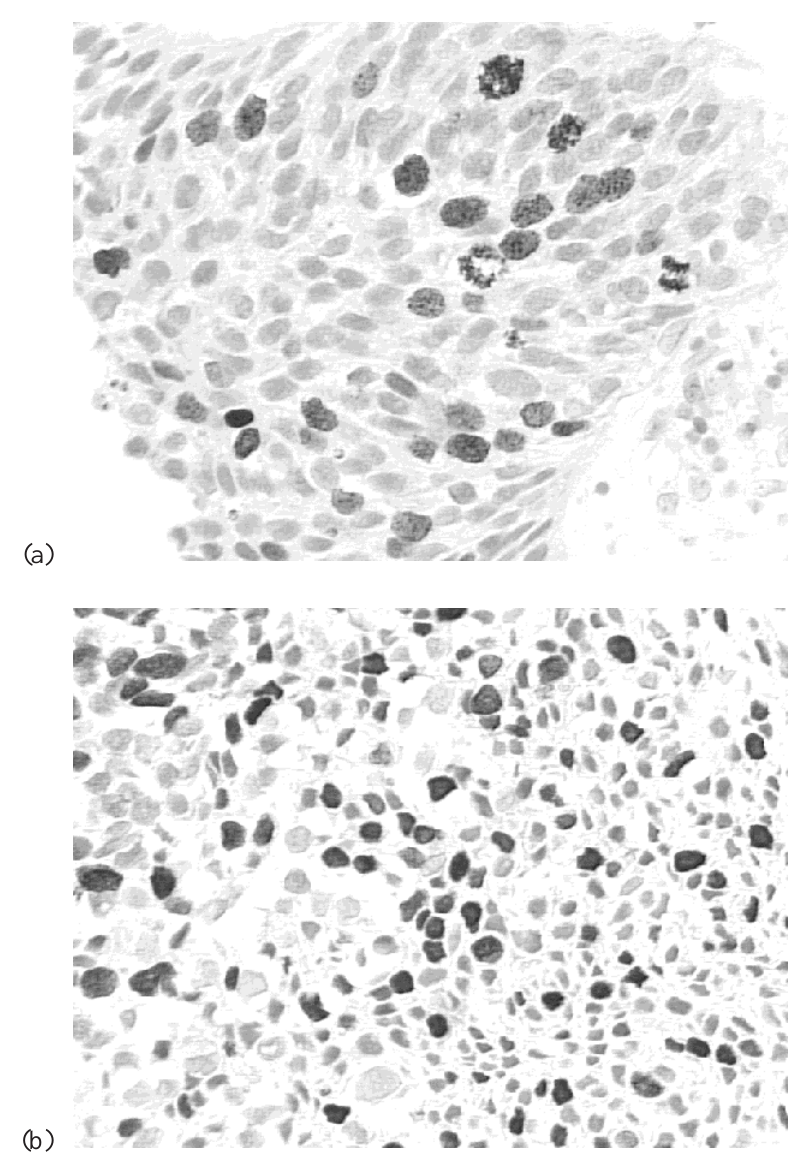
Fig. 1. Typical images of immunohistochemically stained cell